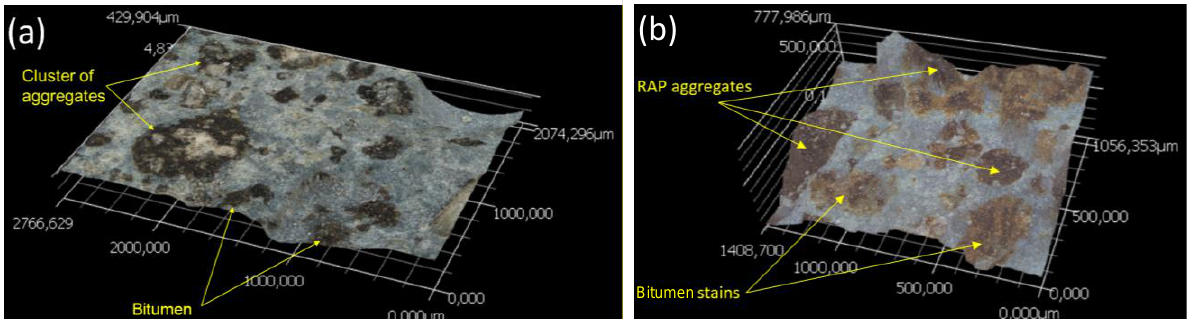
Figure 14. R4M0 ( a ) sawed, ( b ) broken.